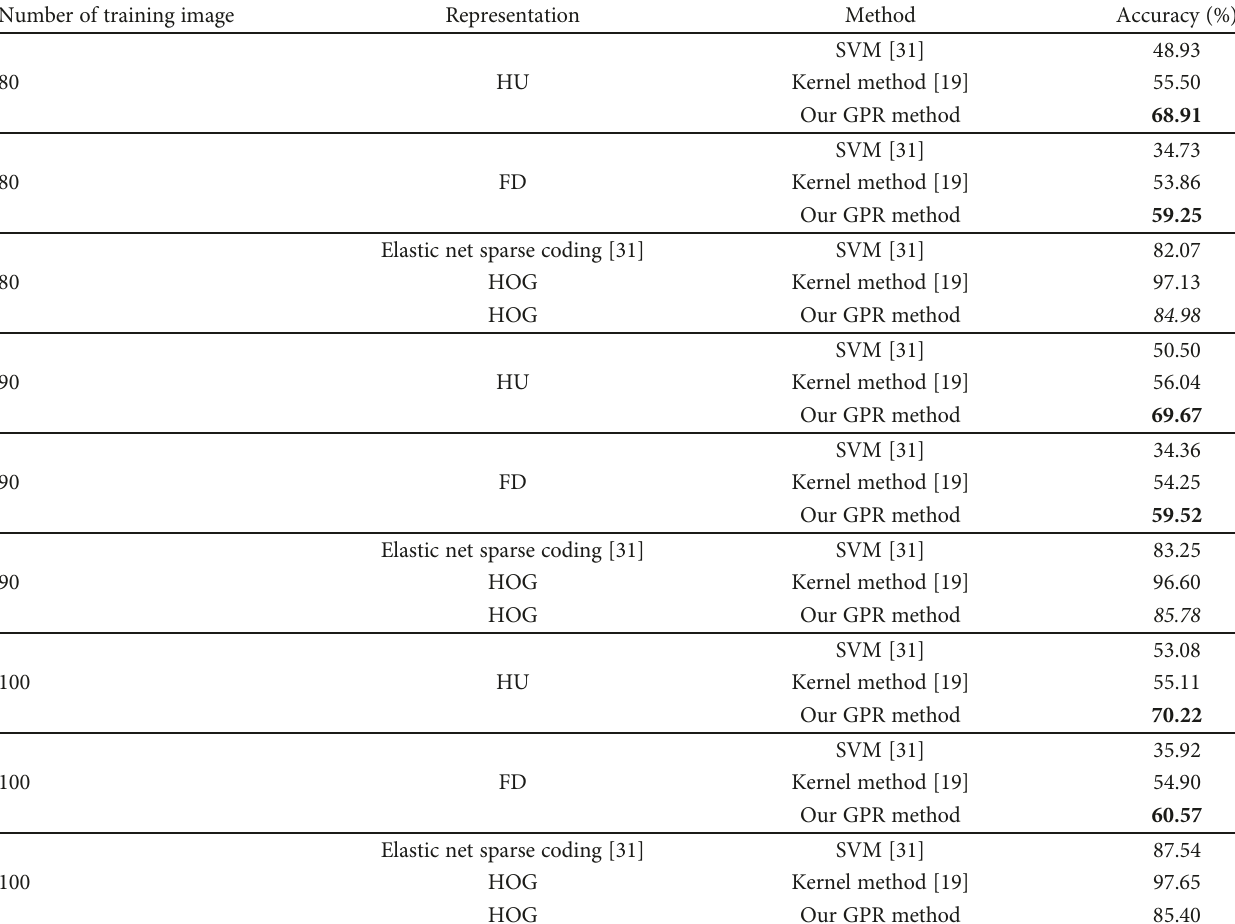
Table 2: Satellite recognition results on BUAA-SID 1.0 and comparison with [19, 31]. Results are in bold if the proposed method performs the best and in italic if the second